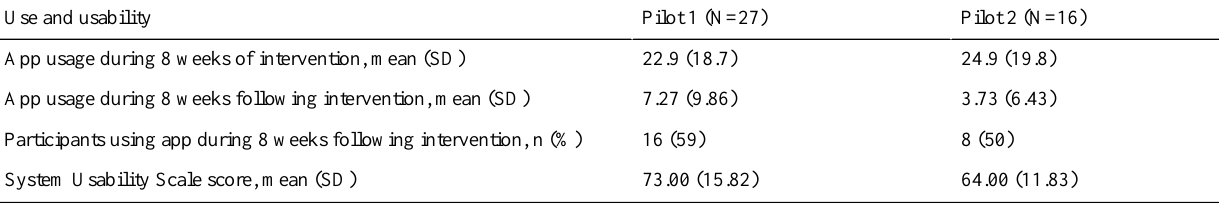
Table 3. App usage and system usability for pilots 1 and 2.